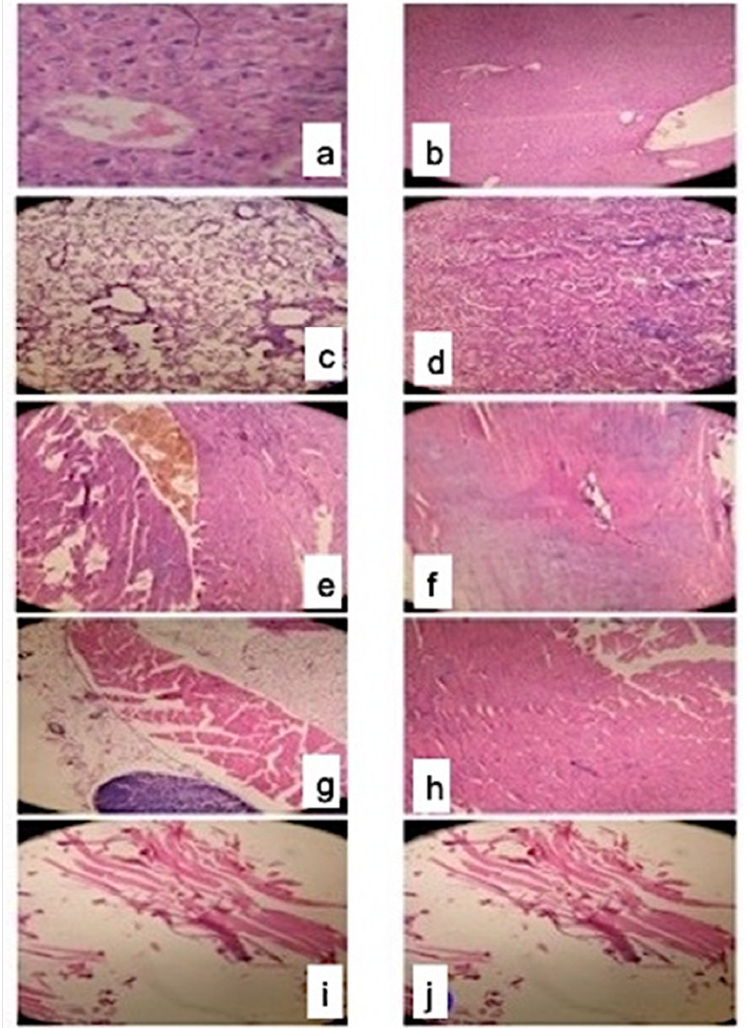
Figure 9. Histopathological evaluation of vital organs and muscles of group I mice (n = 3). ( a —liver,